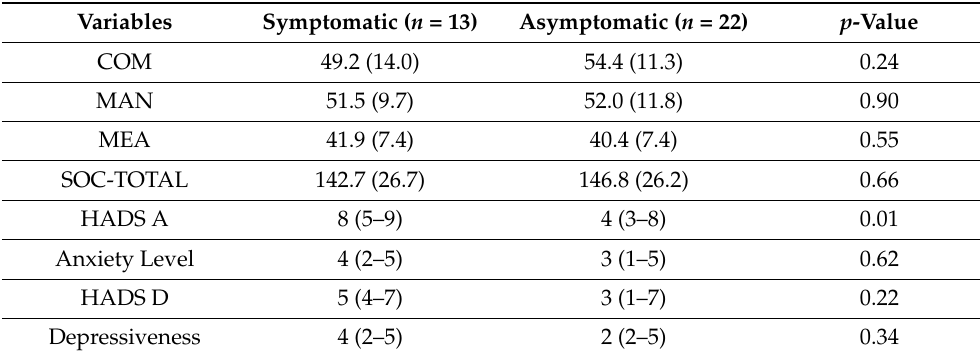
Table 2. The comparison of SOC components and anxiety and depression scales between groups stratified by the presence of symptoms of carotid artery